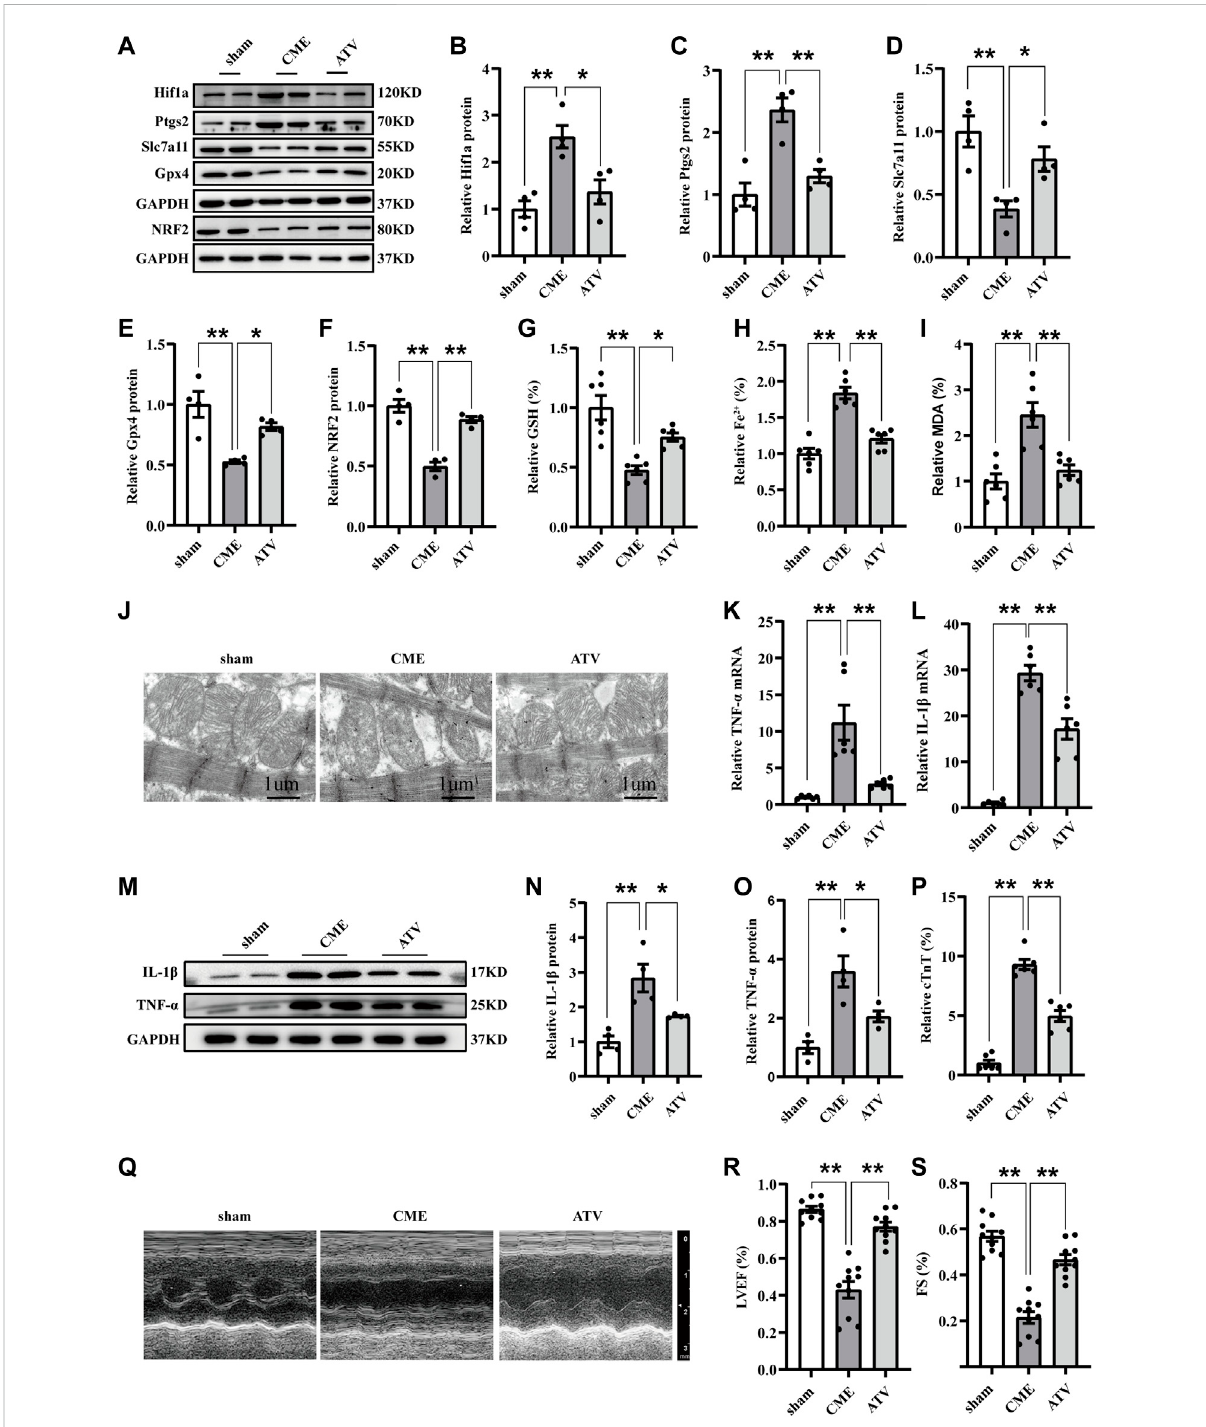
Atorvastatin attenuatedferroptosis-dependent myocardial injury andin fl ammation following CME byinhibitingHif1a/Ptgs2axis. (A – F) Western blotting was performed to determine the protein levels of Hif1a, Ptgs2, Gpx4, Slc7a11, and NRF2 ( n = 4). (G – I) Levels of GSH, Fe 2+ , and MDA in myocardial tissues ( n = 6). (J) Representative images of transmission electron microscopy. Scale bar = 1 μ m. (K,L) RT-qPCR was used to detect the mRNA expression of IL-1 β and TNF- α ( n = 6). (M – O) Western blotting showing the expression of IL-1 β and TNF- α ( n = 4). (P) Serum levels of cTnT were detected in each group ( n = 6). (Q – S) Cardiac LVEF and FS detected by echocardiography ( n = 10). GAPDH served as an internal control was performed to quantitatively normalized the protein data. Data are presented as the normalized mean ± SEM (to sham) or mean ± SEM. Values in shams were averaged and normalized to 1 (A – P) . * p < 0.05. ** p < 0.01. CME: coronary microembolization; Hif1a: hypoxia-inducible factor 1 subunit alpha; Ptgs2: prostaglandin-endoperoxide synthase-2; Gpx4: glutathione peroxidase 4; Slc7a11: solute carrier family 7 member 11; NRF2: nuclear factor erythroid 2-related factor 2; MDA: malondialdehyde; GSH: